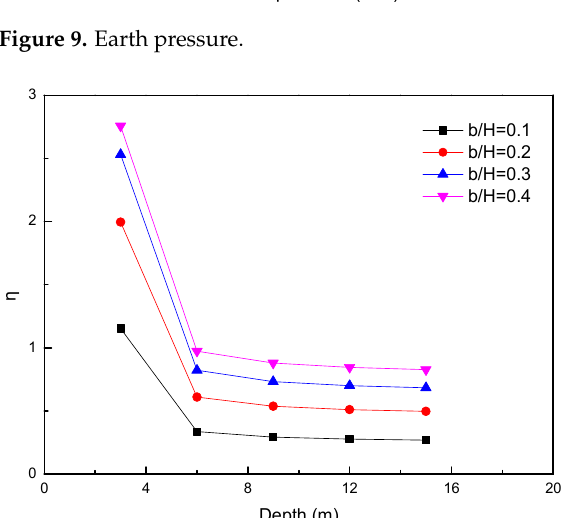
Figure 9. Earth pressure.